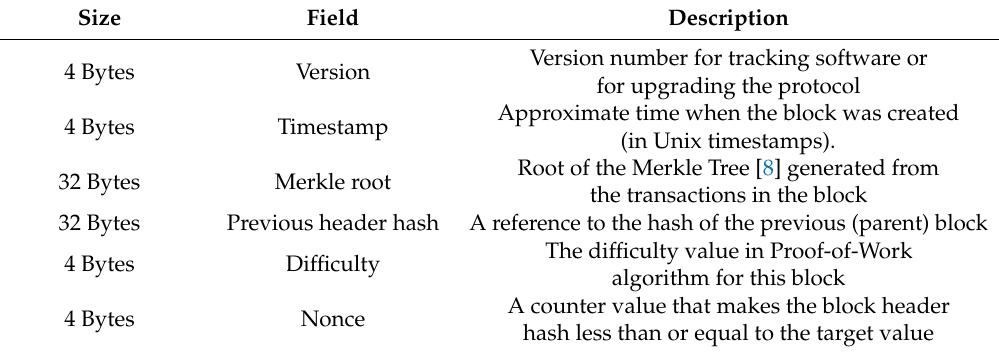
Table 1. Structure of the block header.